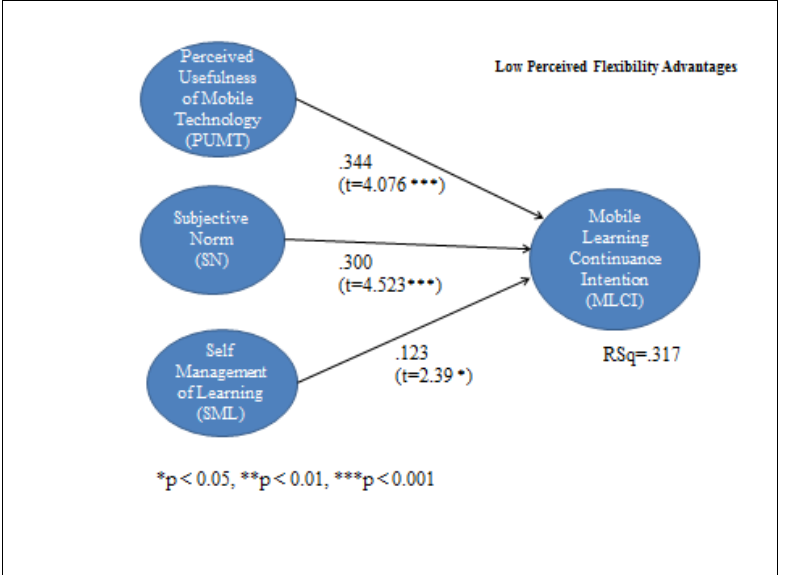
Figure 4. PLS solution for low perceived flexibility advantages